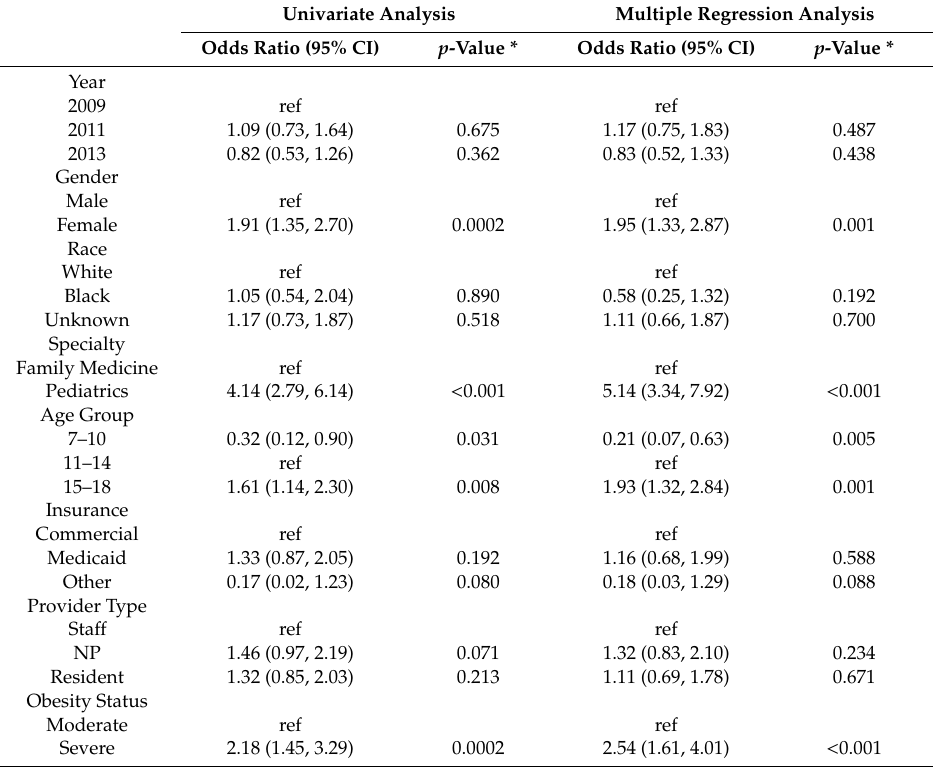
Table 2. Patient and provider factors associated with performance of screening tests.